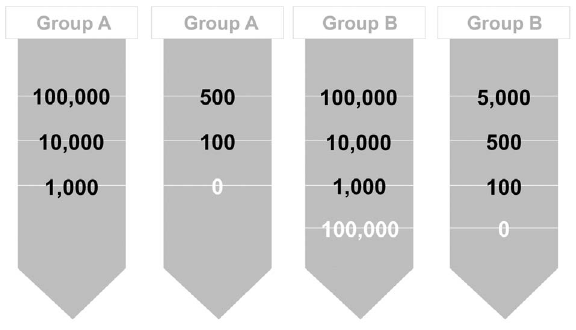
Figure 2. Layers of the agarose phantoms. Layer structure of group A): 2 phantoms contained layers bearing 1,000, 10,000, and 100,000 labeled MSC, and 2 phantoms comprising layers with 0, 100, and 500 labeled MSC. Layer structure of Group B): One phantom contained a layer configuration bearing 1,000, 10,000, and 100,000 labeled MSC as well as a 4 th layer with 100,000 non labeled MSC. The other phantom contained layers with 100, 500, and 5,000 labeled MSC as well as one more layer without MSC. Slices containing no MSC or unlabeled MSC are indicated by white numbers.